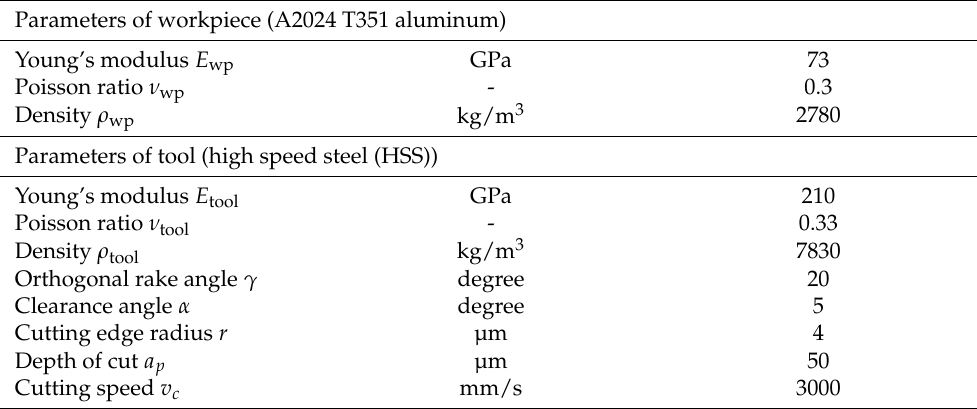
Table 2. Parameters of the 2D orthogonal cutting models with A2024 T351 aluminum, as per [32]. Parameters of workpiece (A2024 T351